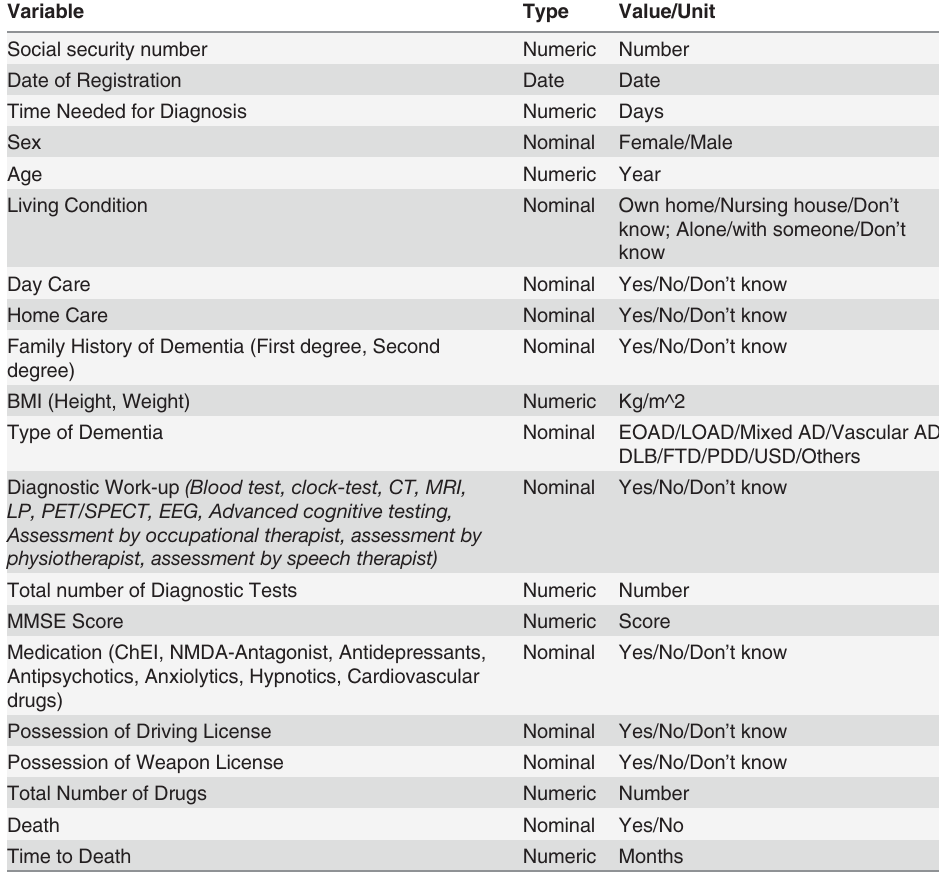
Table 1. List of variables and characteristics recorded in